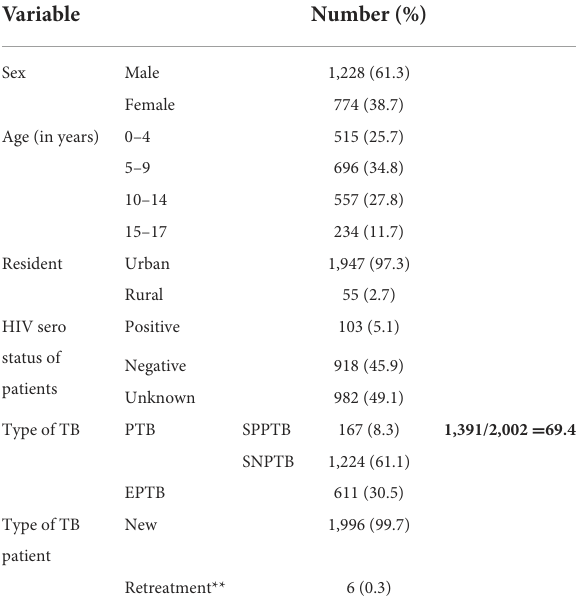
TABLE 2 Tuberculosis types distribution by study participant’s characteristics attending treatment in selected health institutions of eastern Ethiopia,